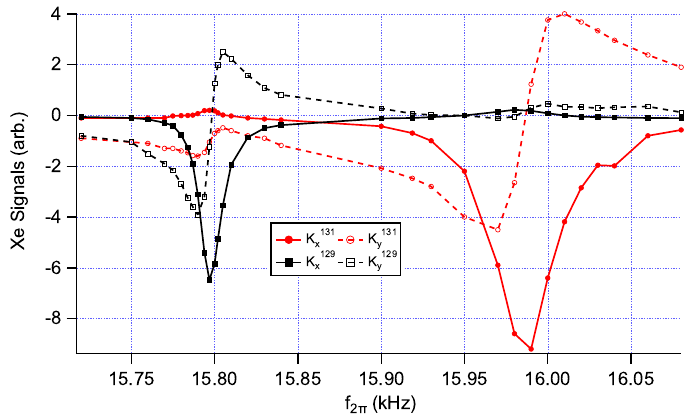
Figure 8. Measurement of cross talk for detection with rectification. The Xe drive frequencies are set such that the two isotopes are not driven on resonance at the same effective bias field magnitude. The in-phase (filled symbols) and out-of-phase (un-filled symbols) components of each isotope’s detection channel (black and red correspond to isotopes a and b , respectively) are shown as the bias pulsing frequency is varied. We see that when isotope a is resonant ( f 2 π ∼ 15.8 kHz) the signal on isotope b ’s detection channel is not flat despite isotope b being driven many linewidths off resonance. Similarly, when isotope b is resonant ( f 2 π ∼ 16 kHz) the signal on isotope a ’s detection channel is not flat despite isotope a being driven many linewidths off